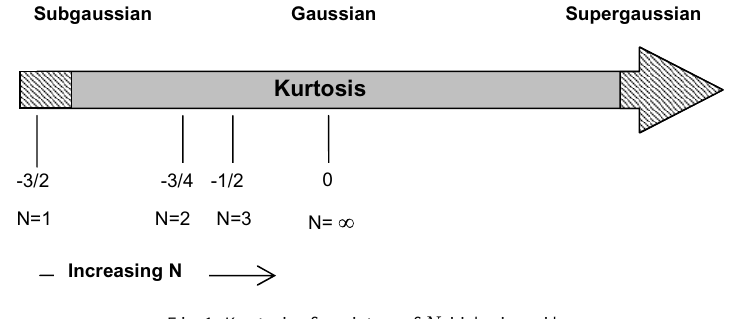
Fig. 1. Kurtosis of a mixture of N i.i.d. sinusoids.